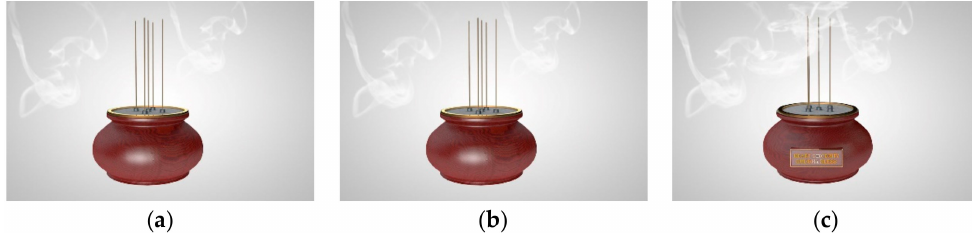
Figure 1. ( a ) Traditional Burner, ( b ) Electronic Burner, and ( c ) Electronic Burner with doctrine